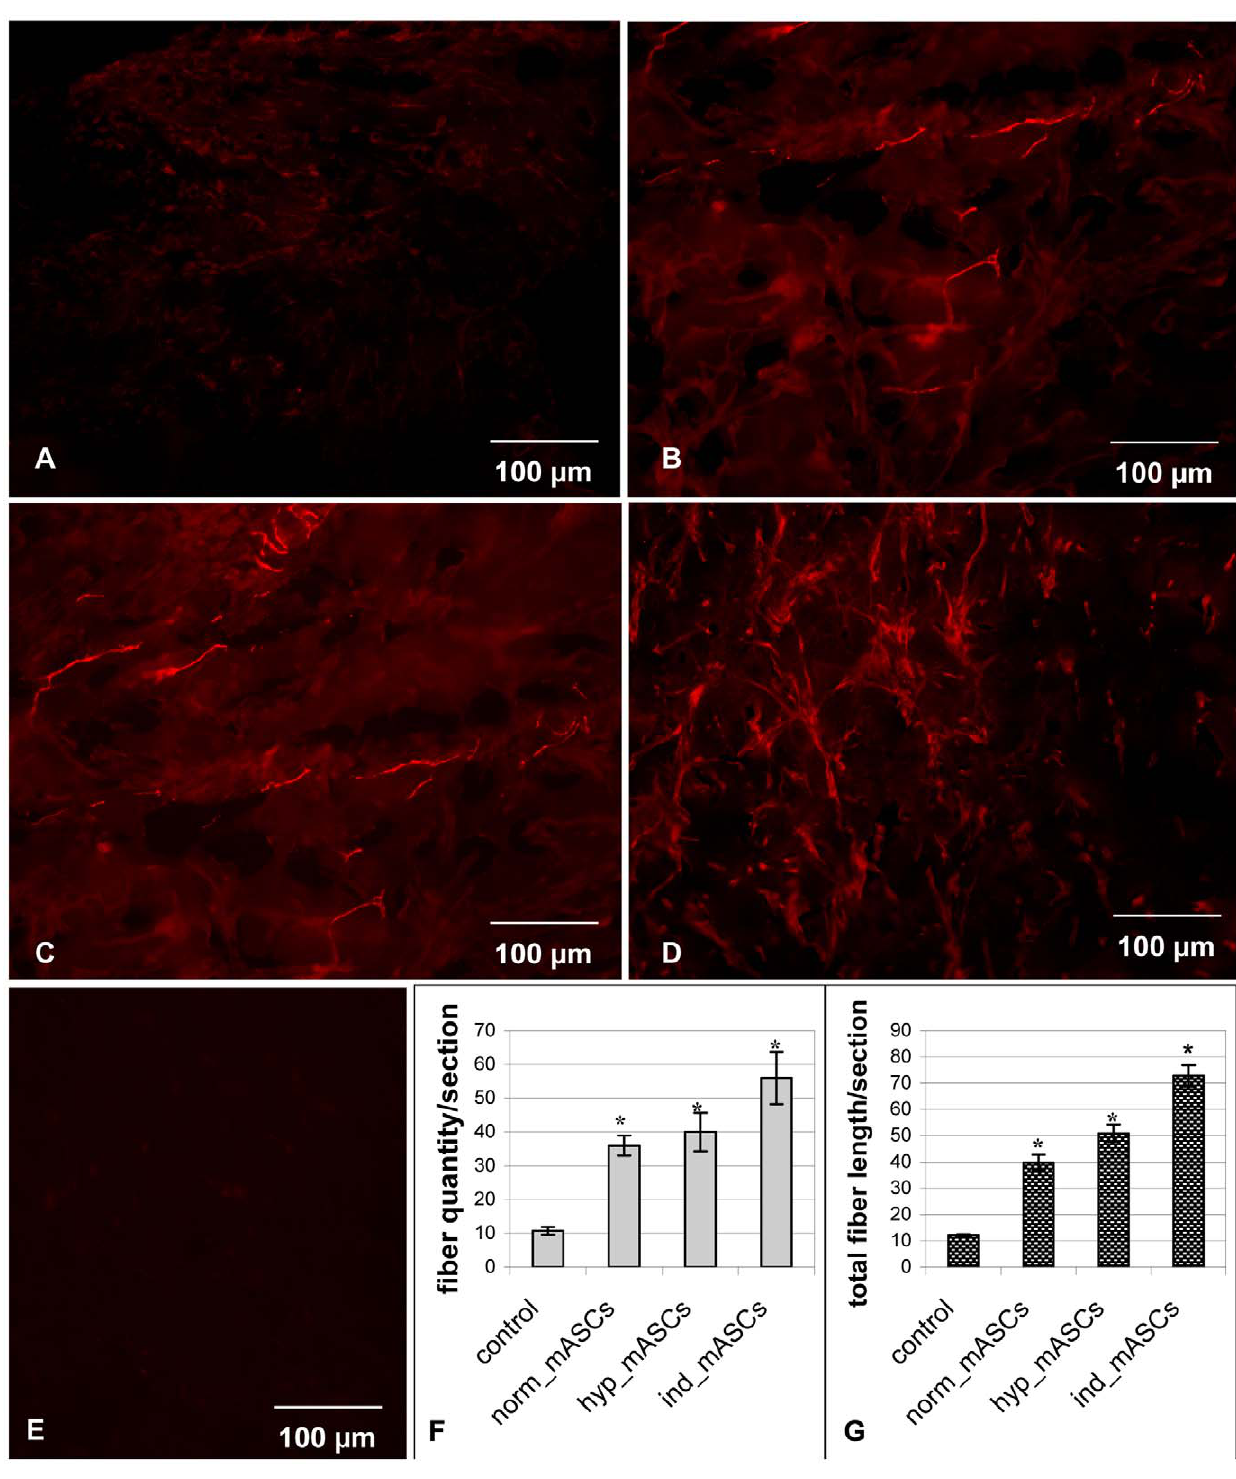
Figure 2. GAP43-positive nerve fibers in matrigel. A–D. - Immunofluorescent staining of frozen sections of matrigels with GAP43 antibodies (red fluorescence). A. – matrigel with growth media only (no cells; negative control). B. – matrigel containing mASCs cultured in normoxic conditions (norm_mASCs). C. - matrigel with mASCs cultured in hypoxic conditions (hyp_mASCs). D. - matrigel containing mASCs which have been cultured in neural differentiation medium prior to incorporation into matrigel (ind_mASCs). E. – frozen matrigel sections stained with non-specific IgGs. F. – density of nerve fibers (pieces) per section. G. – total length (relative units) of nerve fibers. * - p , 0.05.